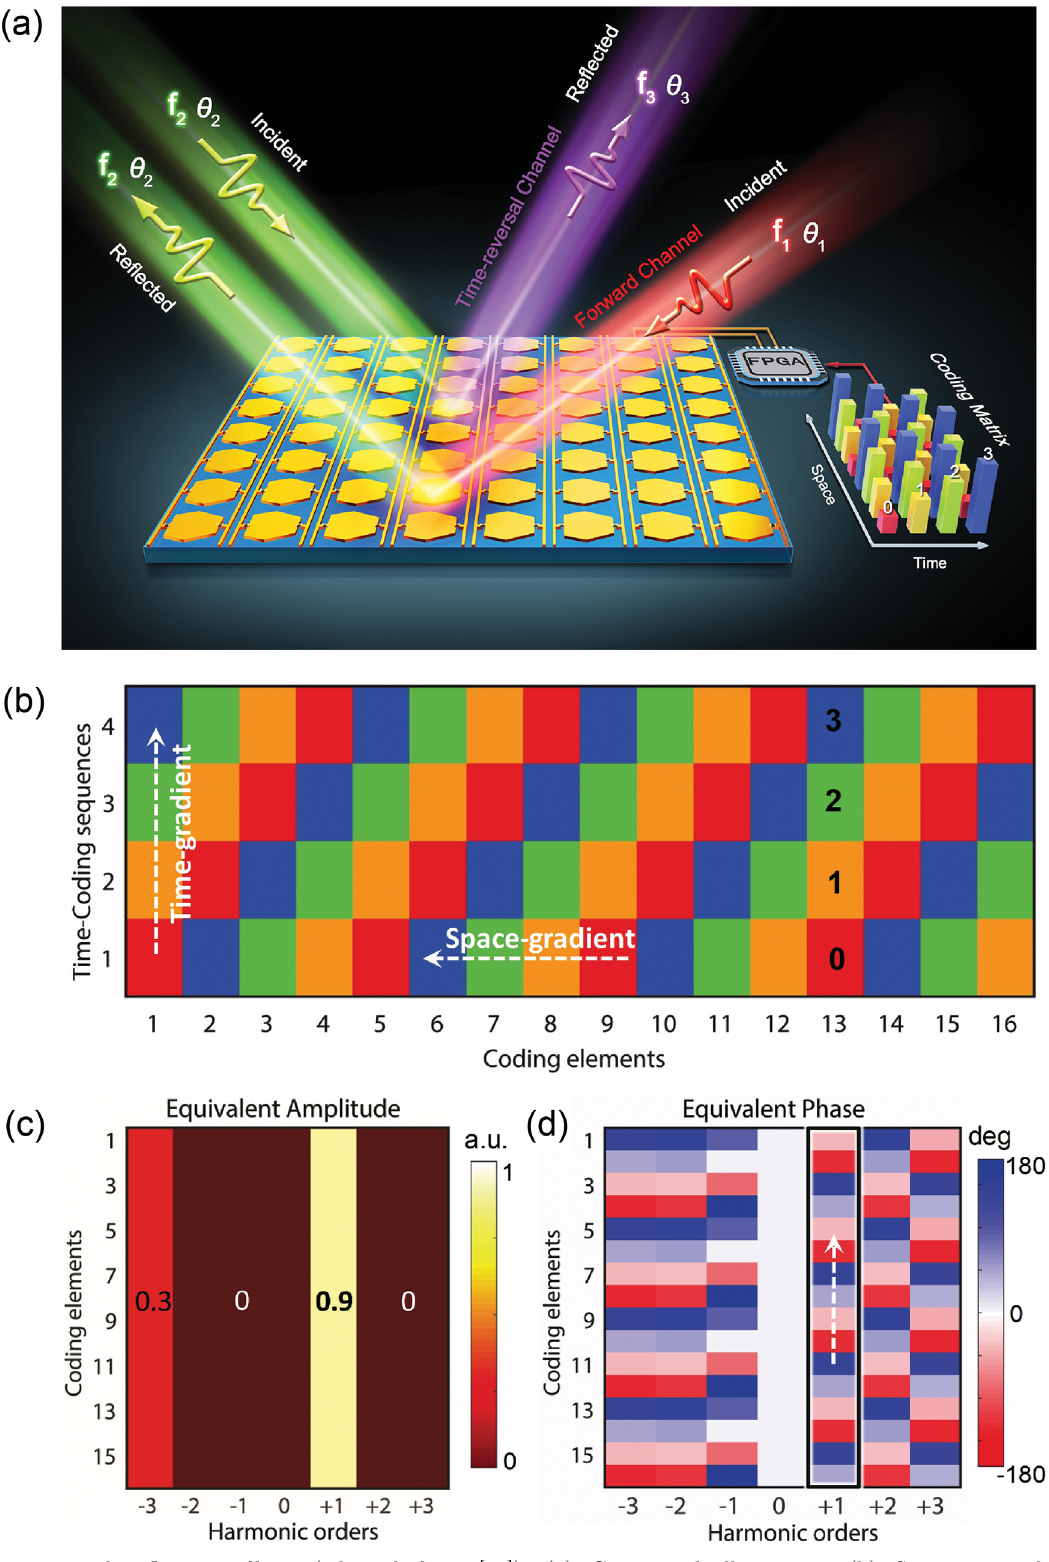
Fig. 2. Nonreciprocal re fl ection effects (adapted from [30]). (a) Conceptual illustration. (b) Space-time-coding matrix. (c, d) Equivalent amplitudes and phase distributions, respectively, at the various harmonic